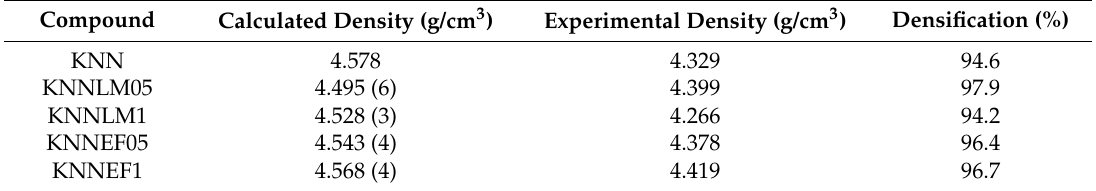
Table 2. Theoretical and experimental density and densification percentage for sintered compounds.